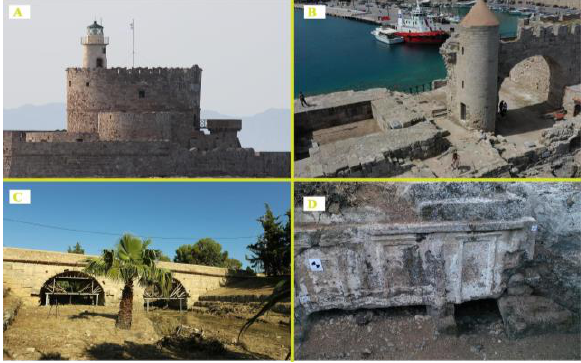
Figure 1 . The four pilot areas in